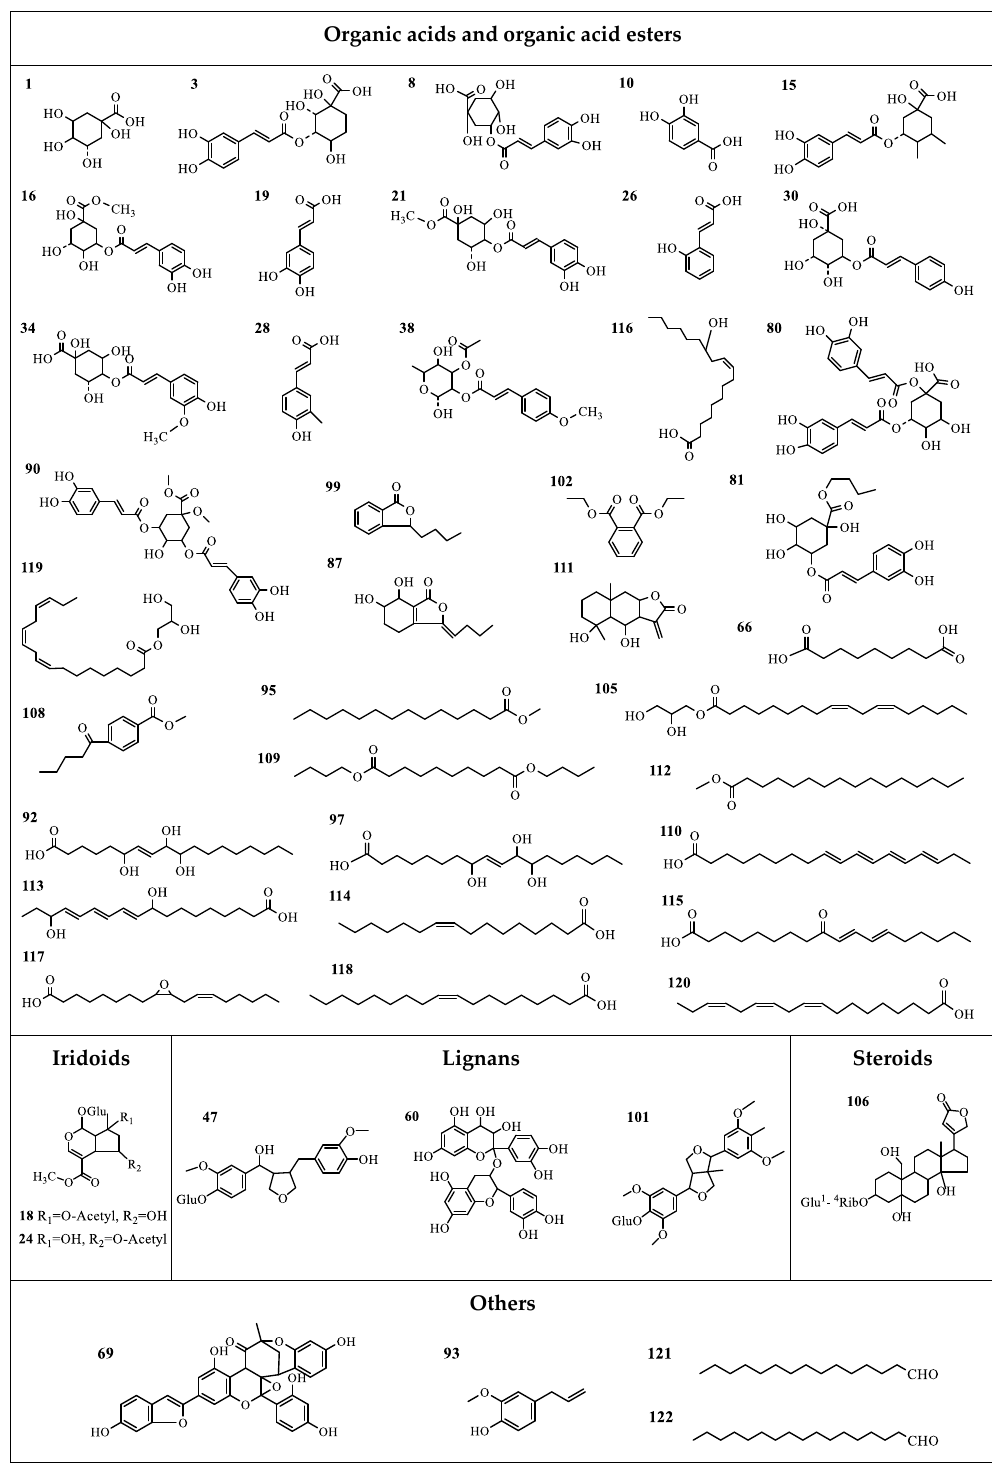
Figure 2. Chemical structures of compounds identified in CML and IML.